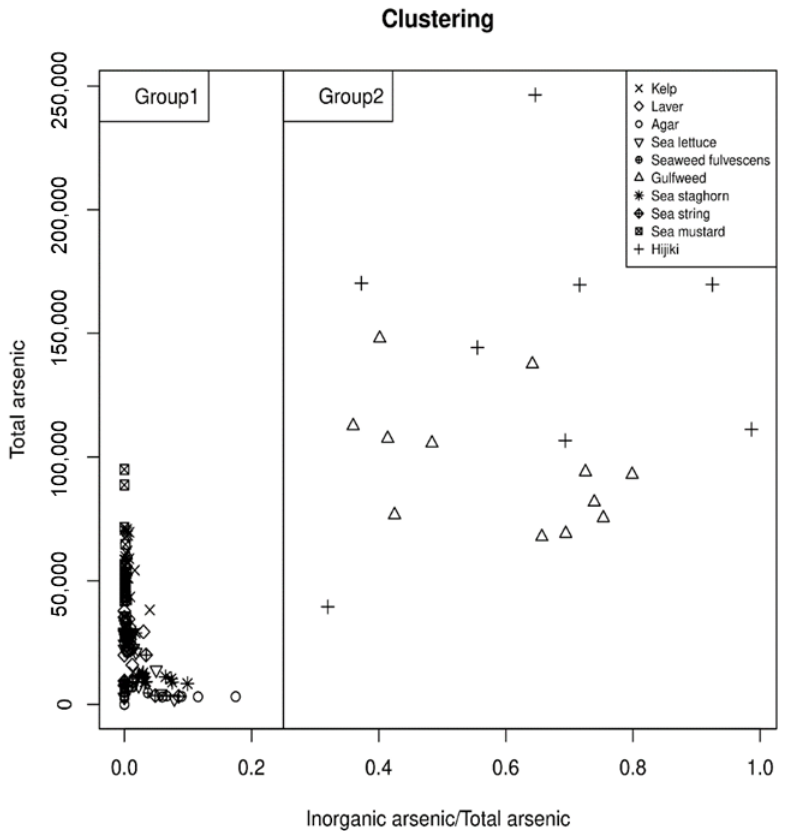
Figure 3. K-means clustering analysis according to the tAs and iAs / tAs distribution pattern of each seaweed group.